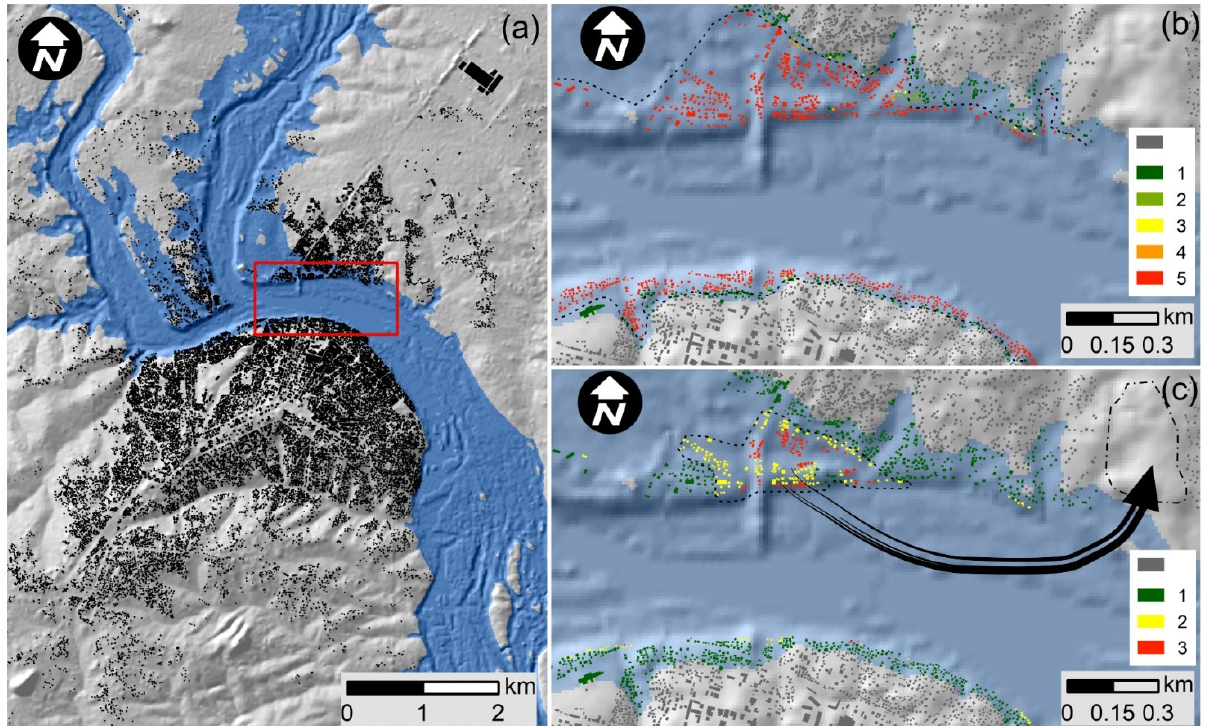
Figure 8. Spatial extent of the flooded area ( a ) for the January 2015 flooding event using the Copernicus DEM data. People dragging flood hazard analysis ( b ) using the Russo et al. [64] model (1 = low hazard for adults and children; 2 = low hazard for adults and high hazard for children; 3 = moderate hazard for adults; 4 = significant hazard for adults; 5 = extreme hazard for adults). “Building stability for floods” hazard model ( c ) using the Pistrika and Jonkman [65] model (1 = inundation damage; 2 = partial damage; 3 = total destruction). The black dashed lines ( b , c ) show the demarcation of high hazard areas, while the black dash-dot lines and black arrow show the possible population rearrangement area from present results.